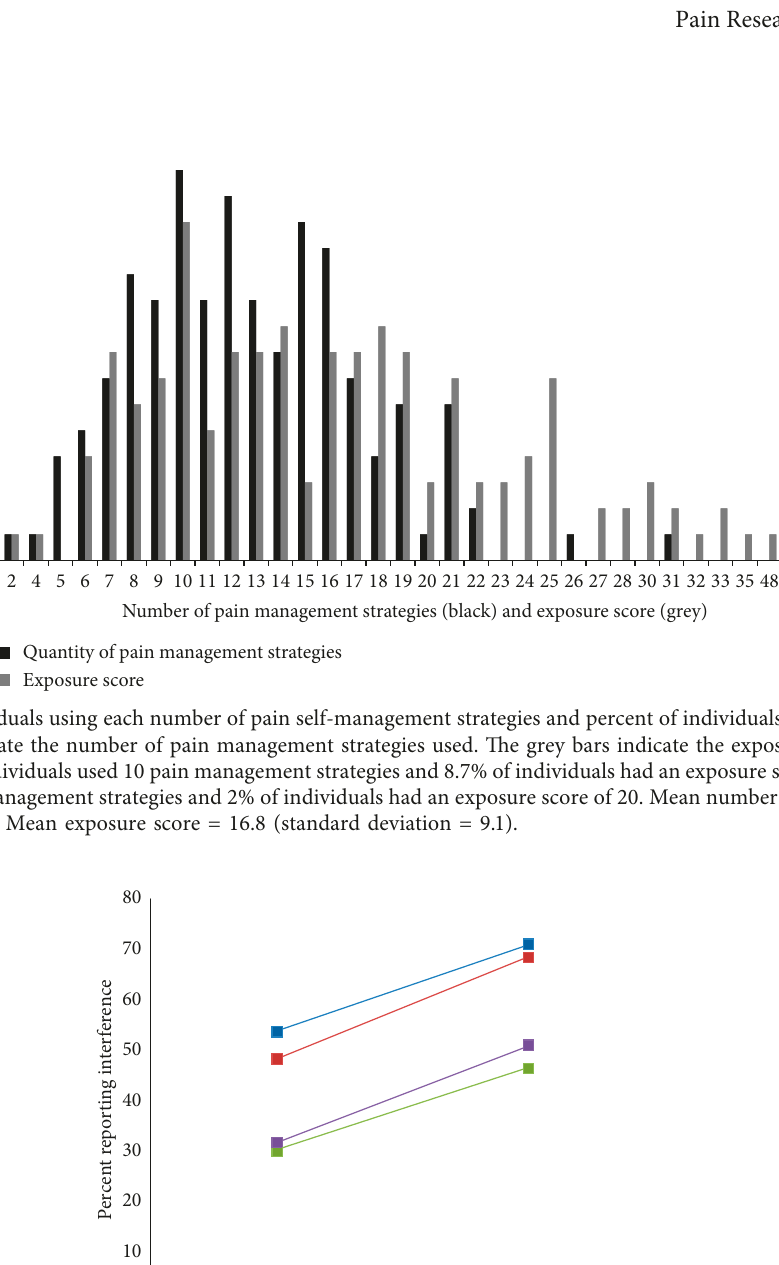
interference on daily activities: (cid:31) 2.31 (95% CI 1.18–4.50). Work interference on work: (cid:31) (cid:31) (cid:31) 1.98 (95% CI 1.01–3.88). For example, Figure 2 shows (cid:31) (cid:31)